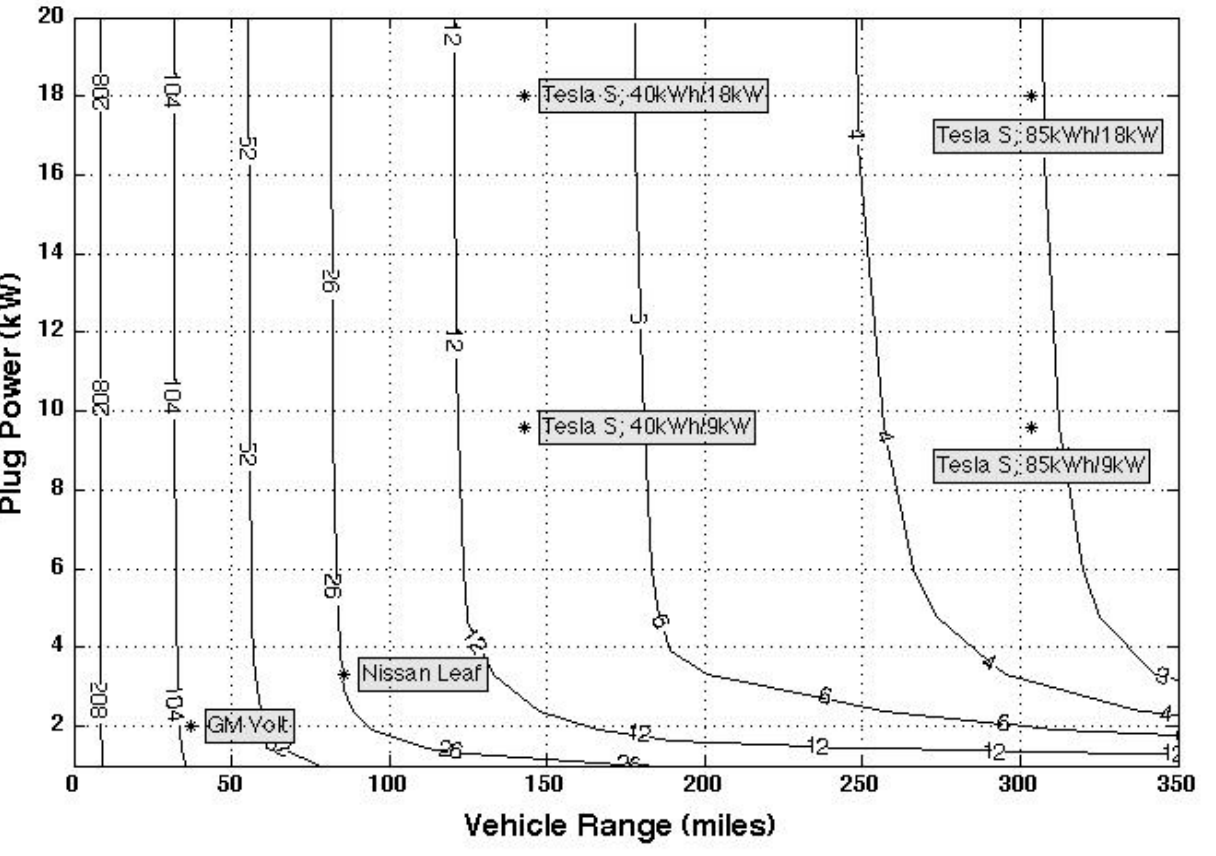
Figure 5. Adaptation days per year of Home charging only. Reprinted by permission, from Pearre [24]. Again, the axes are vehicle range and charging power, thus each point on the space represents an EV of given range and charging power. Figure 5 shows, for example, that the original Nissan Leaf, with 86 miles of range and a 3 kW charge power, would require driver adaptation 26 times a year, or every other week. As another illustrative example, the GM Volt would need either its built-in gasoline range extender, or some other adaptation, about 100 times a year (about twice a week). In contrast, an 85 kWh Tesla Model S would require adaptations slightly over 3 days a year. All these Figure 5 adaptation counts are based on charging only at